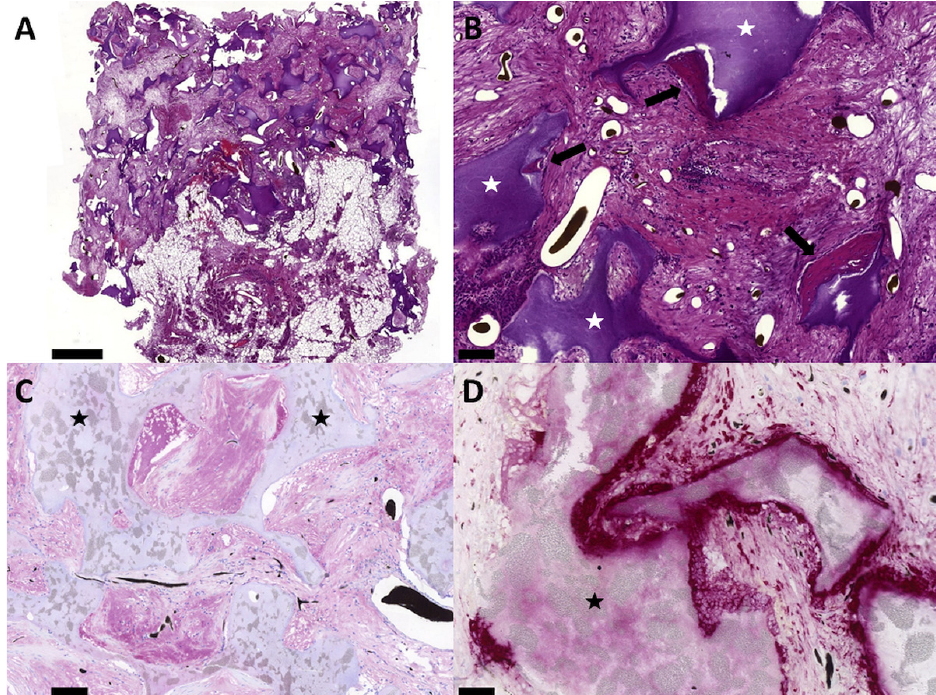
Figure 8. Bone formation, presence of alkaline phosphatase and osteoclasts. Only in the T17b EPC and MSC coimplantation group was bone formation detected ( A , B ). Bone formation occurred in the vascularized construct parts ( B ). Alkaline phosphatase was detected in the matrix in group C (purple-colored in C ). Osteoclasts were found around the HA/ß–TCP granula in group C (red-colored in D ). Bold bars indicate the newly formed bone tissue and the white/black stars indicate the HA/ß–TCP granula. Scale bar = 1 mm ( A ), 100 µm ( B , C ) and 50 µm ( D ).